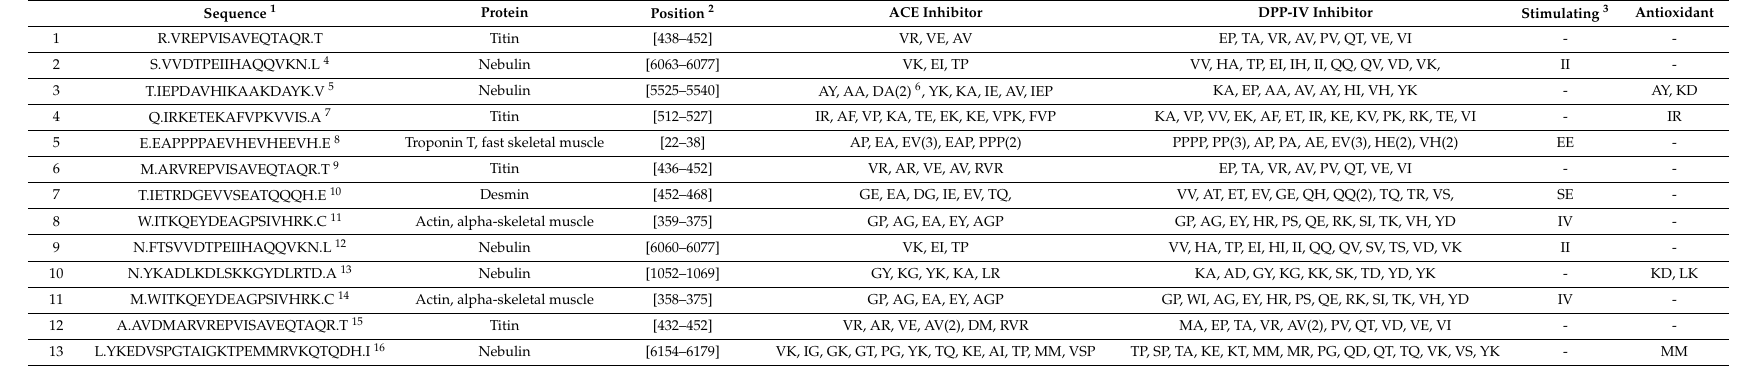
Table 2. List of peptide sequences common for conventional meat. ACE: angiotensin-I converting enzyme; DPP: dipeptidyl peptidase. Sequence